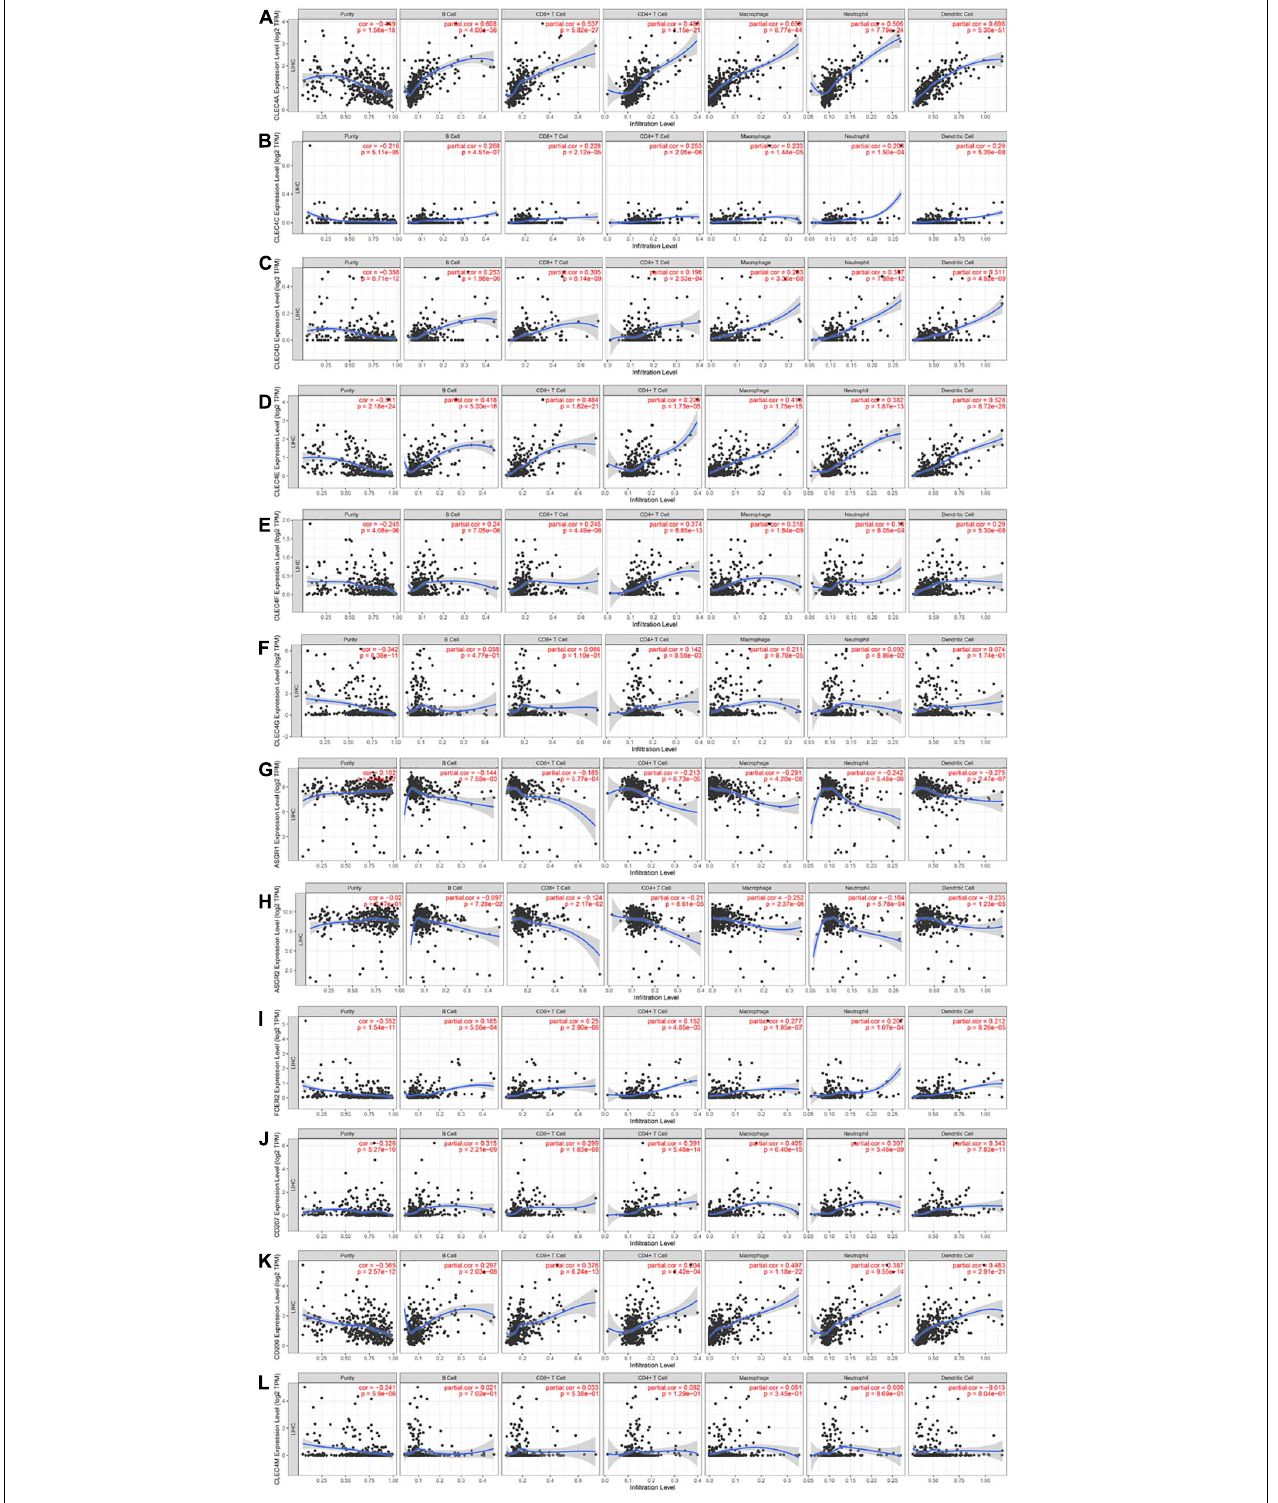
FIGURE 7 | The correlation between CLEC4s and immune cell infiltration (TIMER). The correlation between the abundance of immune cell and the expression of (A) CLEC4A, (B) CLEC4C, (C) CLEC4D, (D) CLEC4E, (E) CLEC4F, (F) CLEC4G, (G) CLEC4H1, (H) CLEC4H2, (I) CLEC4J, (J) CLEC4K, (K) CLEC4L, and (L) CLEC4M in